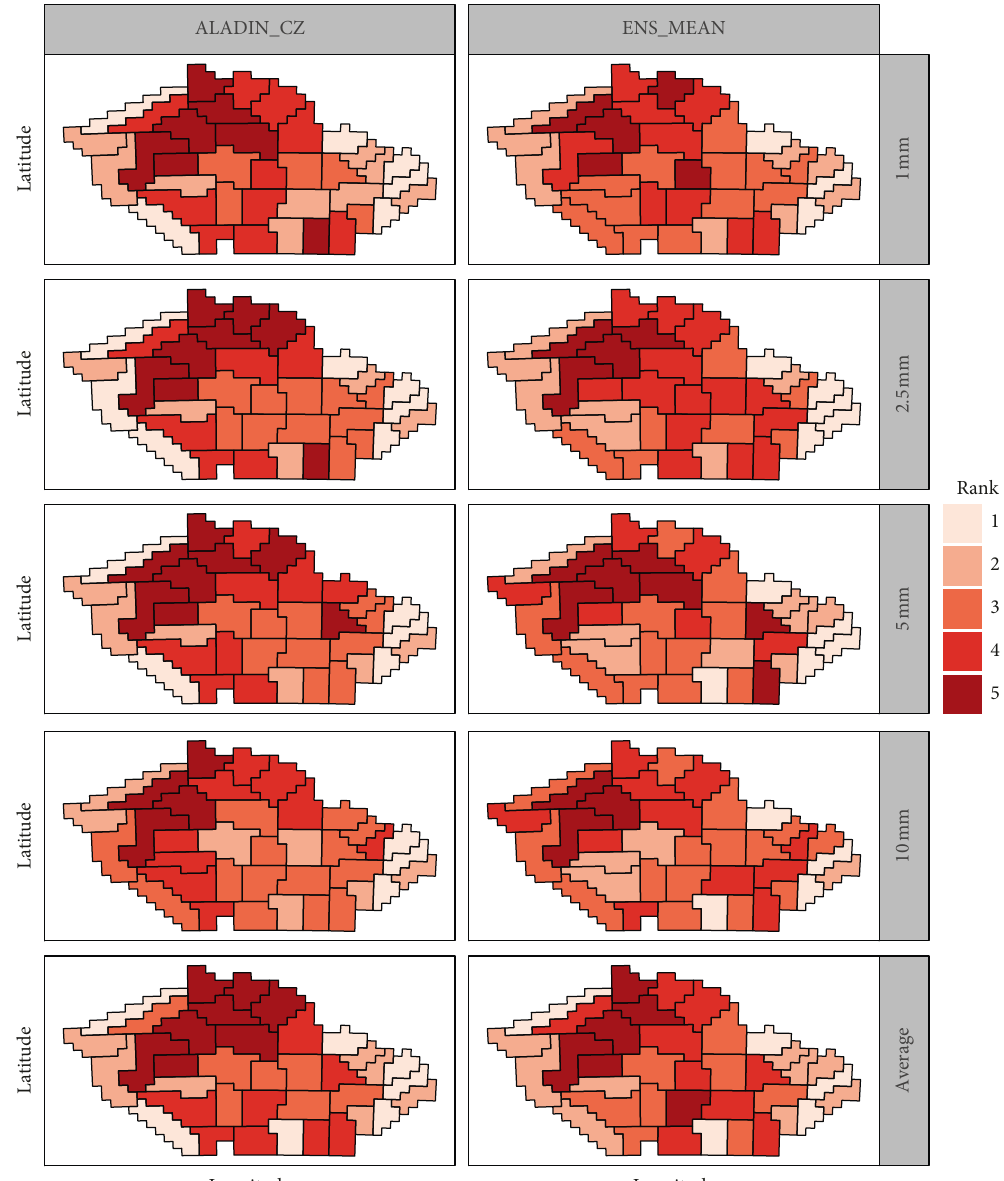
Figure 7: Ranking of forecast accuracy in dependence on threshold in the individual hydrological regions. Regions are ranked from 1 to 5, where 1 means the best forecast (light red) and 5 means the poorest forecast (dark red). Results are shown for ALADIN and MEAN. The last row presents average rank of 1, 2.5, 5, and 10mm